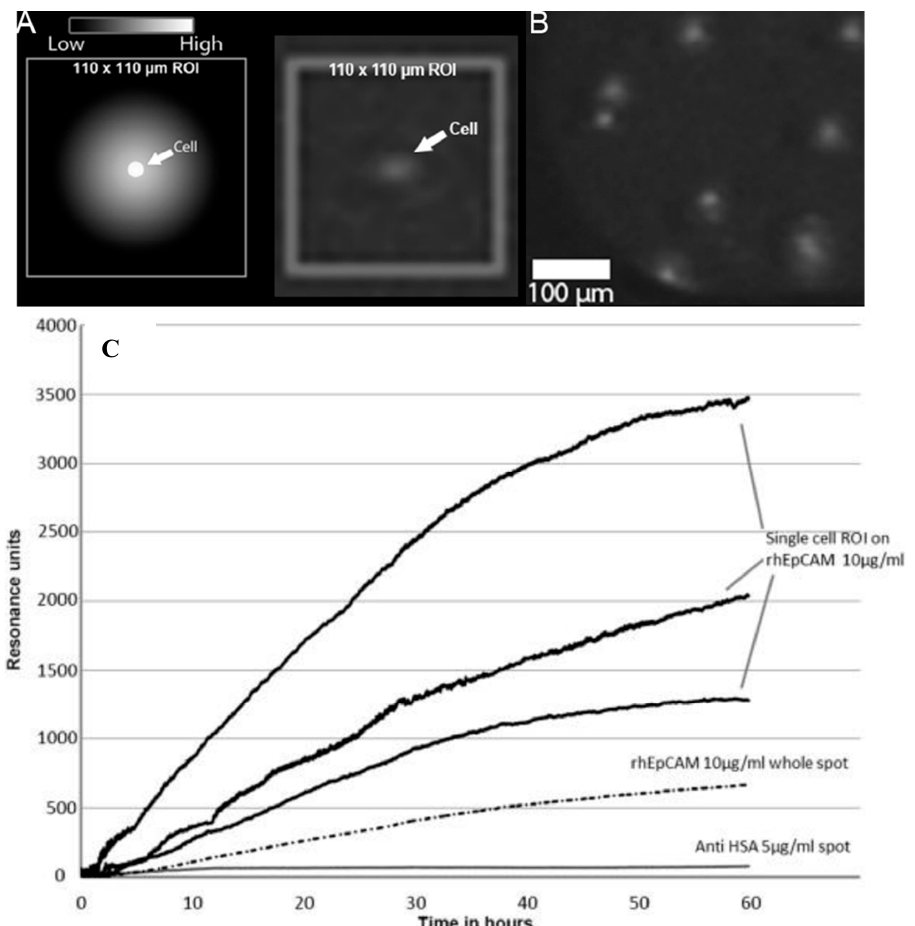
Figure 4. Single-cell antibody secretion monitored with SPRi. Panel ( A ): Schematic representation of cell that secretes antibodies; the sensor surface captures the secreted molecules in a halo around the cell. Panel ( B ): SPR-image of VU1D9 cells on top of the sensor surface with secreted anti-EPCAM antibodies. Panel ( C ): SPR sensorgram showing the variation of single-cell production of anti-EpCAM by VU1D9 cells. Noise levels are high due to very small, 110 µm 2 sized Regions of Interest. As a reference, anti-HSA and rhEpCAM whole spot averaged signals with large Region of Interests are shown. The signals were zeroed in order to compensate for the background.